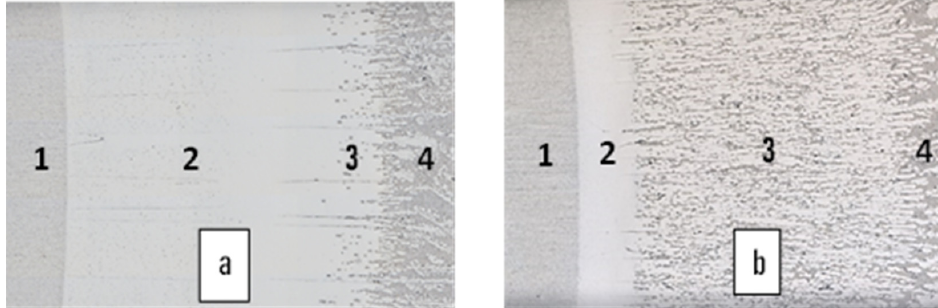
Figure 15. Microstructure of the initial mushy zone of B2F1 ( a ) and B2F5 ( b ) 1: non melted part, 2 and 3: initial mushy zone, 4: melted part. and 3: initial mushy zone, 4: melted